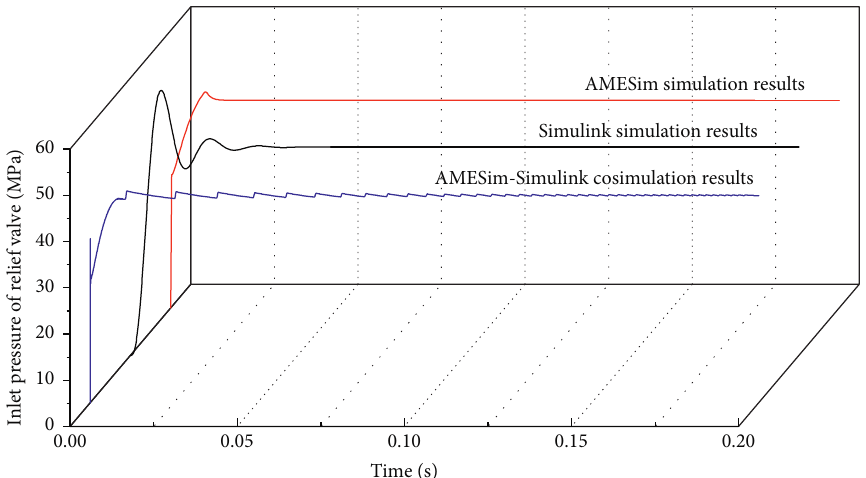
Figure 27: Comparison of simulation results.